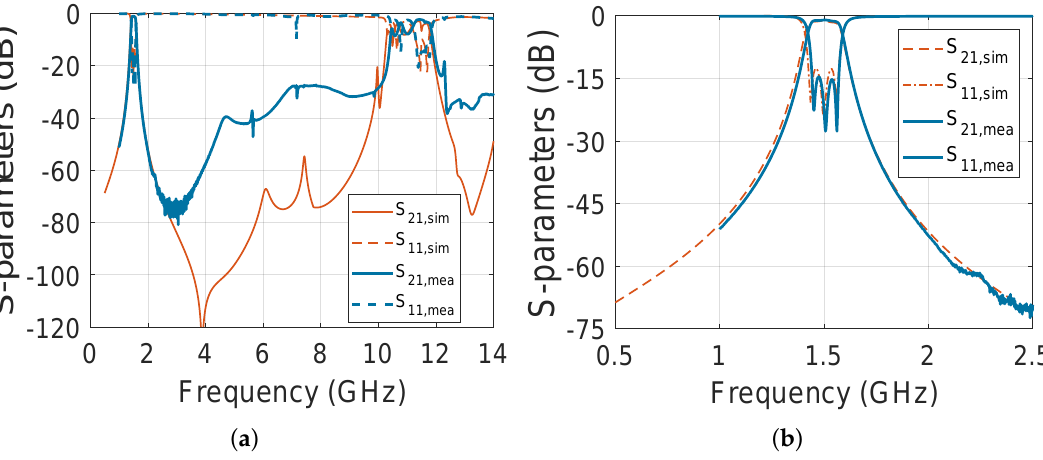
Figure 12. Measured and simulated results of the three-pole BPF: ( a ) wideband response and ( b ) filter